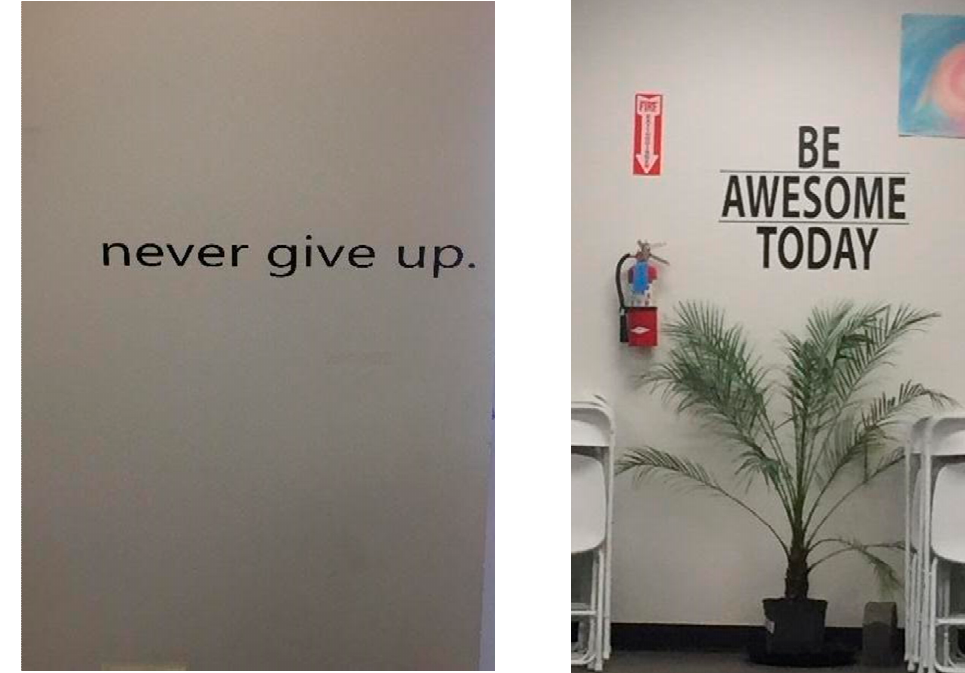
Figure 2. High expectation messages.